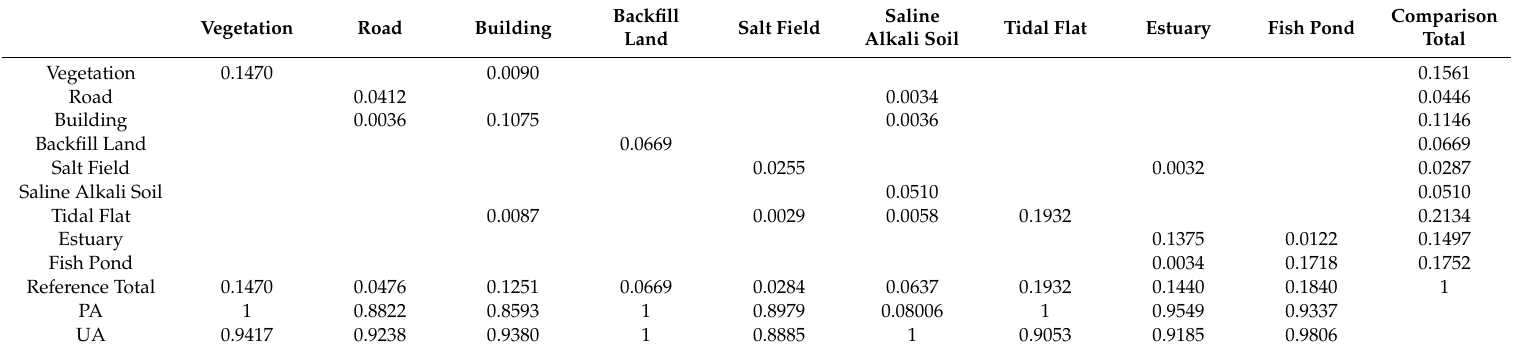
Table 6. Estimated population matrix of the RF method in the WV-2 image with additional texture features.